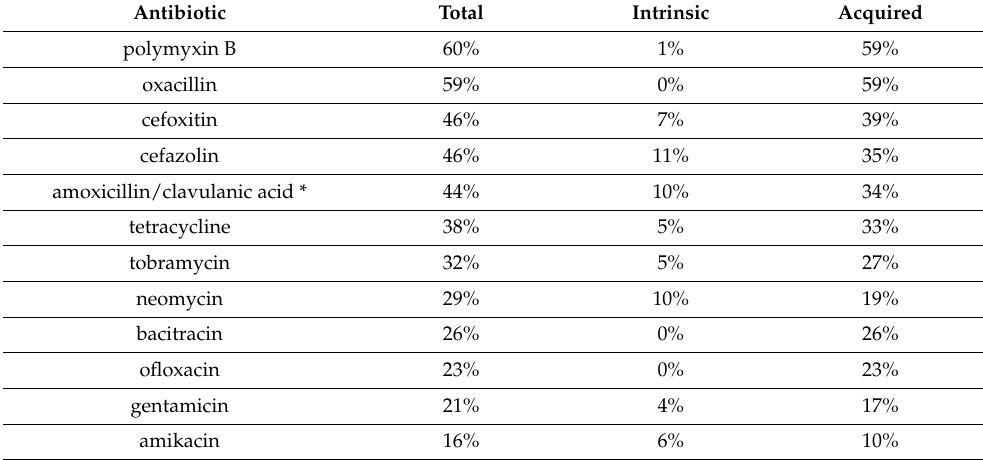
Table 2. Resistance profile of isolates from corneal stromal ulcer samples from 2018–2021. Percentage (%) of resistant bacterial species from patient samples presented as combined resistance (TOTAL; in- trinsic and acquired resistance together), intrinsic resistance only (INTRINSIC), or acquired resistance only (ACQUIRED). The number of isolates is 167 for each antibiotic in the TOTAL column exceptfor oxacillin, which numbered 29. * = although amoxicillin/clavulanic acid is not used topically, data for this antibiotic are presented here since it is often used postoperatively as a systemic antibiotic.